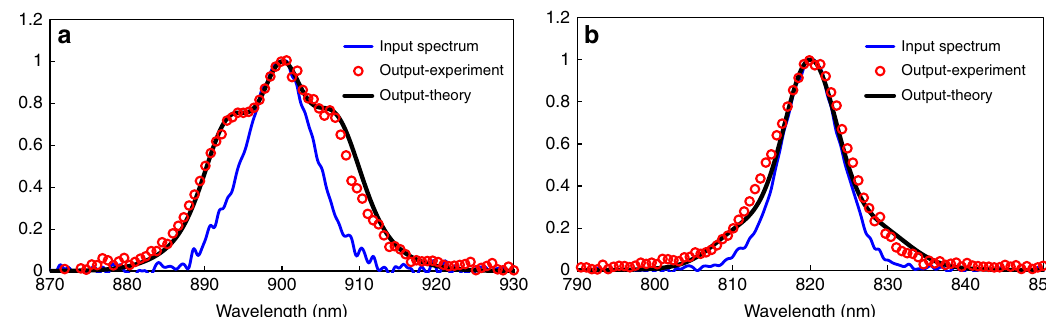
Figure 4 | Nonlinear spectral broadening from the 3nm sample. A similar setup as the z -scan measurement is used with the sample placed at the focus for spectral broadening measurement, and the power meter at the open aperture branch is replaced by an optical spectrometer. Spectrum of an optical pulse (open red circles) measured after passing through the 3nm MQW for incident wavelength at 900 ( a ) and 820nm ( b ) using incident power of 650 and 750mW. In the case of 820nm, the self-phase modulation (SPM)-induced spectral broadening can only be seen at the spectral wings and the nonlinear phase shift is estimated to be 0.6 p . In the case of 900nm, where the Kerr coefficient is at a resonance peak, the SPM-induced spectral broadening is much more obvious and the nonlinear phase shift is estimated to be 0.88 p . The input spectrum is shown by blue solid curves.